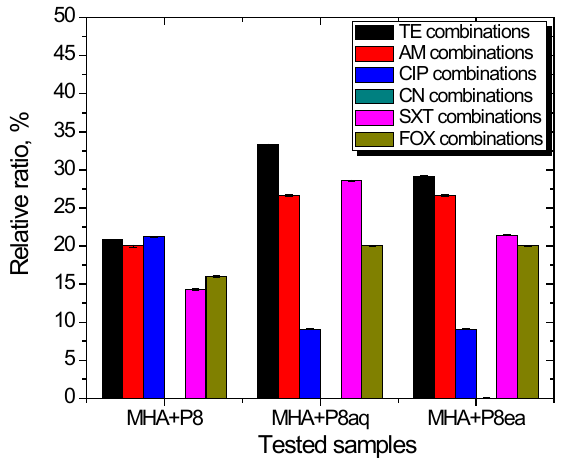
Figure 14 : E. coli ATCC 8739